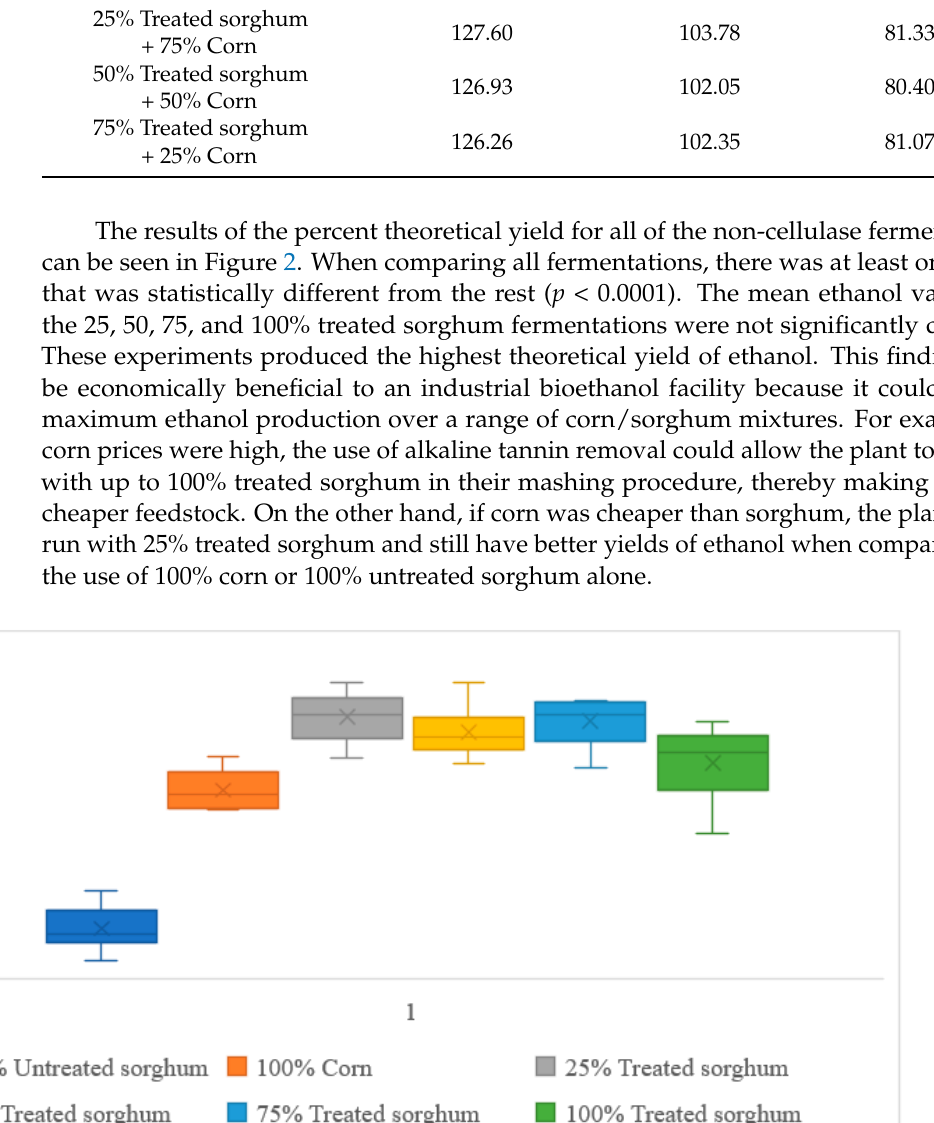
Table 4. Theoretical yield (%) for mixtures of corn and treated sorghum, no cellulase. Treatment